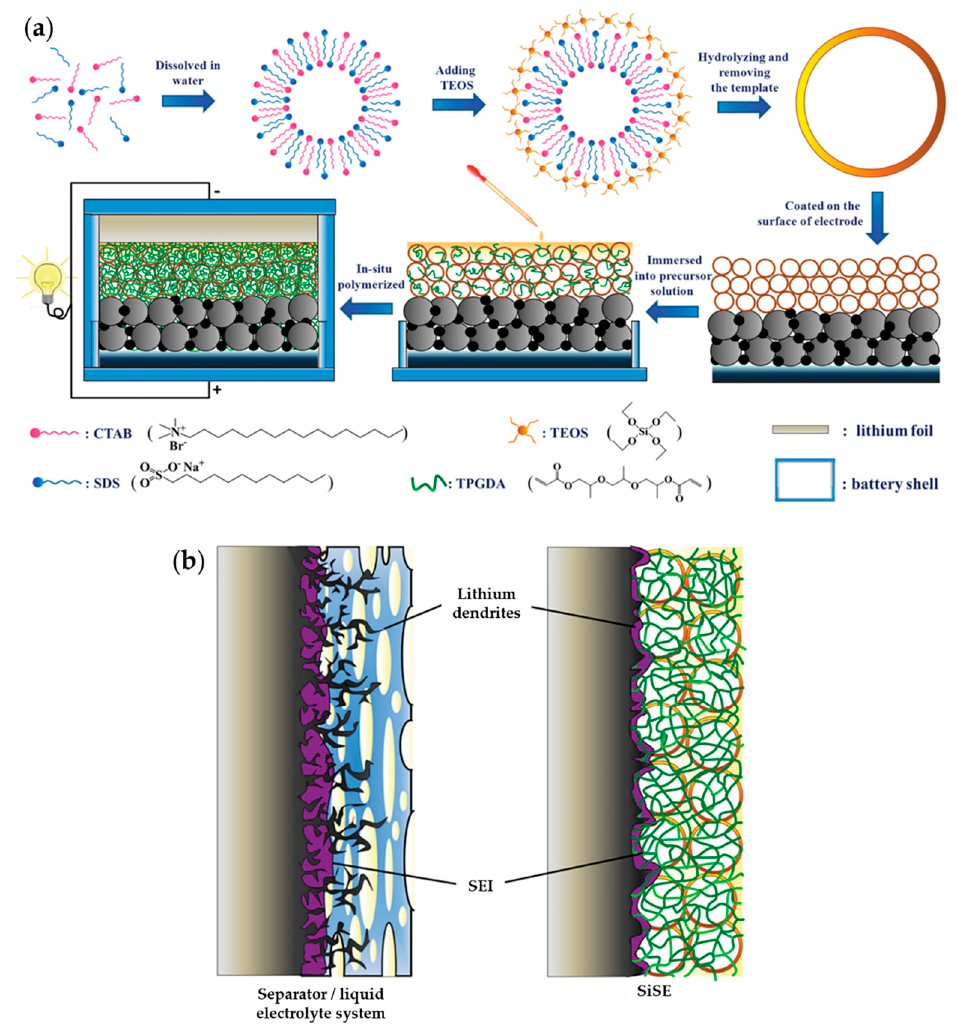
Figure 16. ( a ) Illustration for preparation steps of SiSE. ( b ) Comparison of SiSE to separator/liquid electrolyte system. Reprinted with permission from [161]. Copyright (2016) John Wiley and